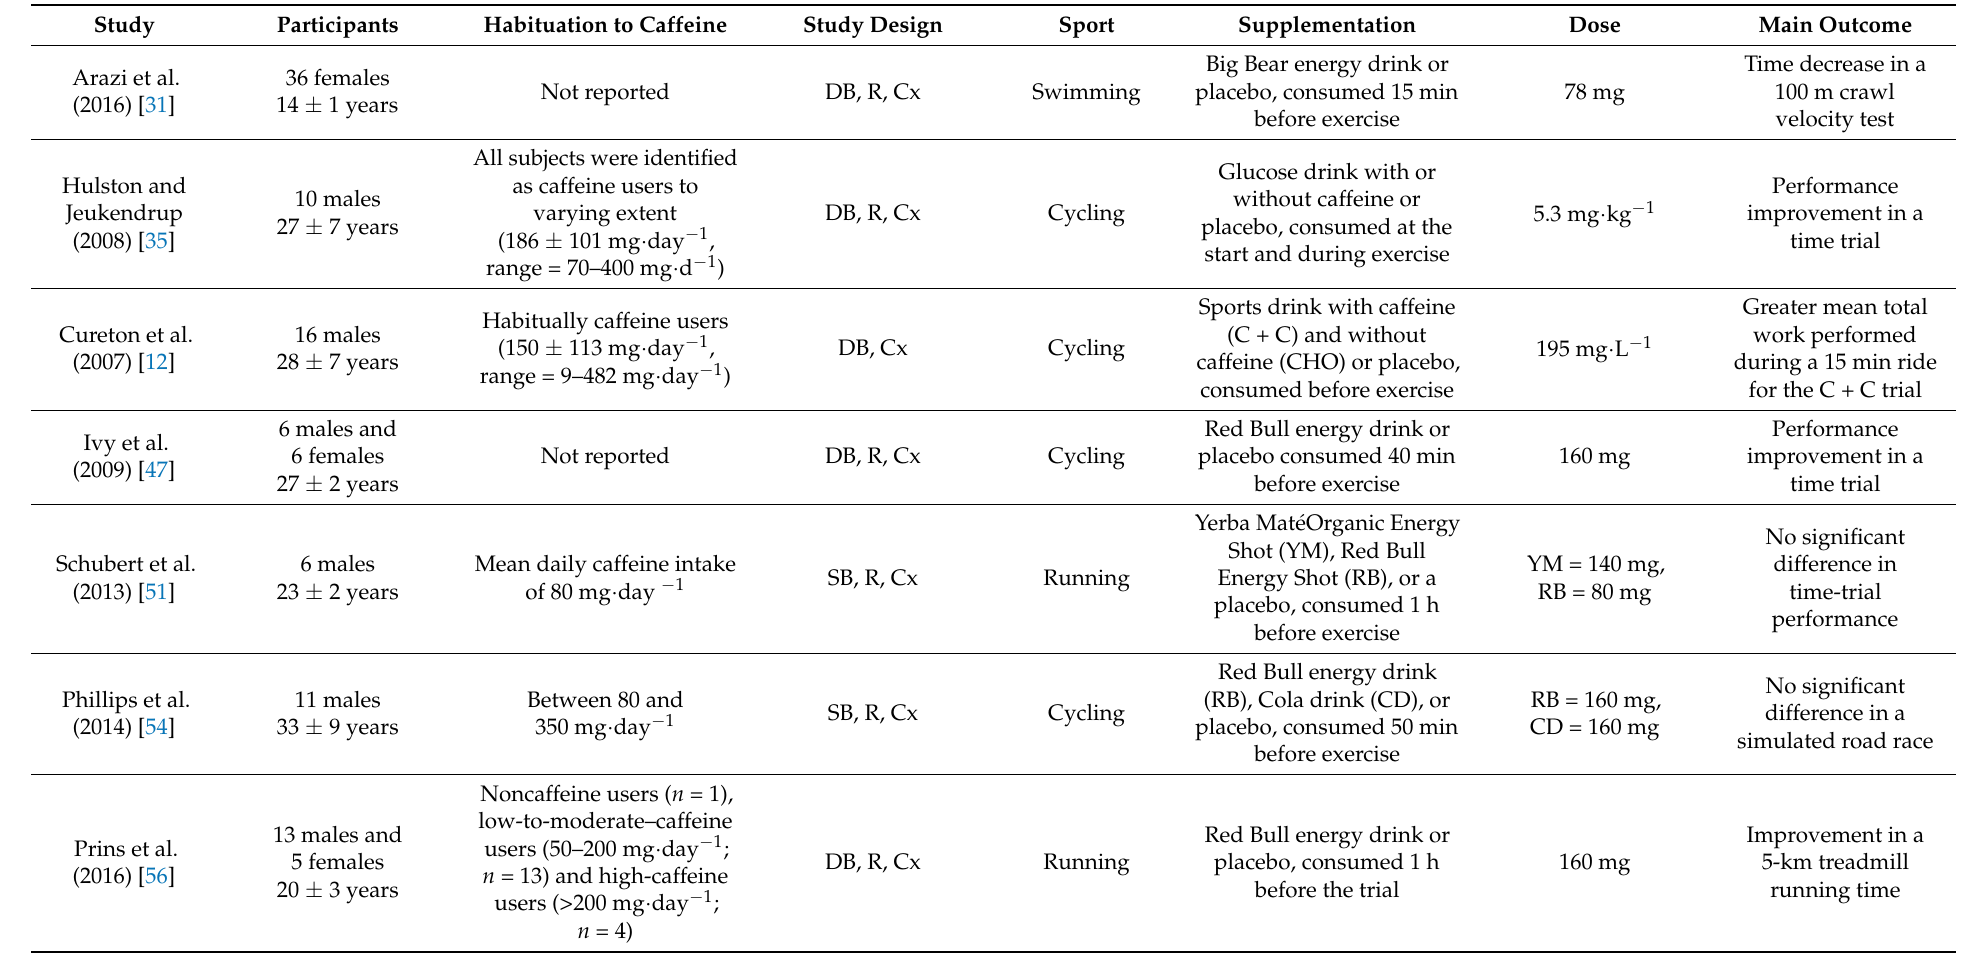
Table A1. Investigations in endurance-based sports